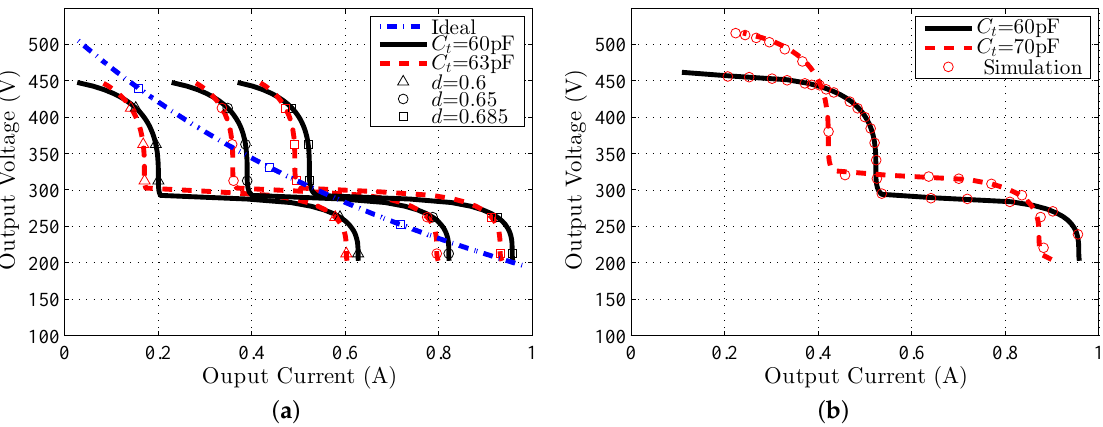
Figure 4. Output voltage to output current curves for the circuit in Figure 2: ( a ) ideal case (dash-dot line) and considering two values for parasitic capacitances (solid and dashed lines) when different duty cycles (triangle, circle and square markers) were used; ( b ) comparison between the numerical results and the data obtained from computer simulations for the two parasitic capacitances.